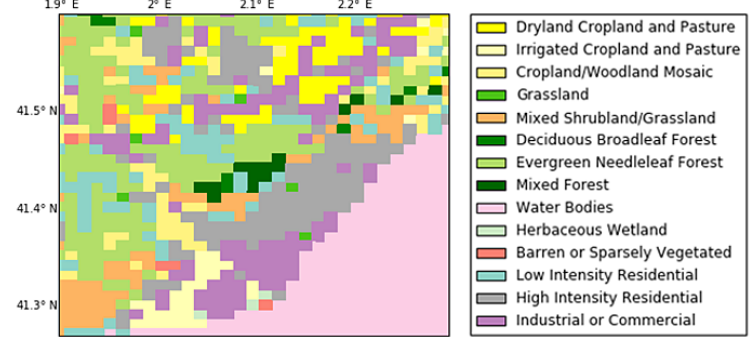
Figure 3. Distribution of the land-use types used in the WRF simulation. They were mapped from the CORINE dataset to the USGS classes.